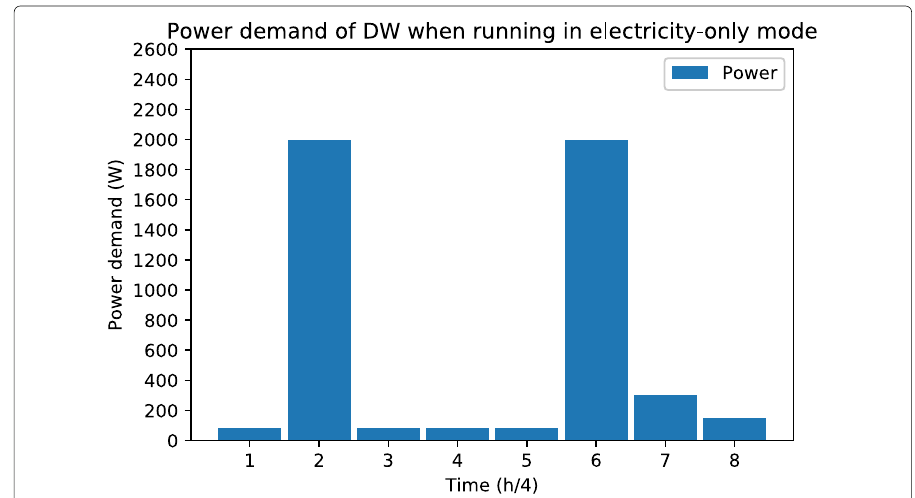
Fig. 3 Example of demand profiles of a hybrid appliance (DW): electricity only (Stamminger et al. 2008)